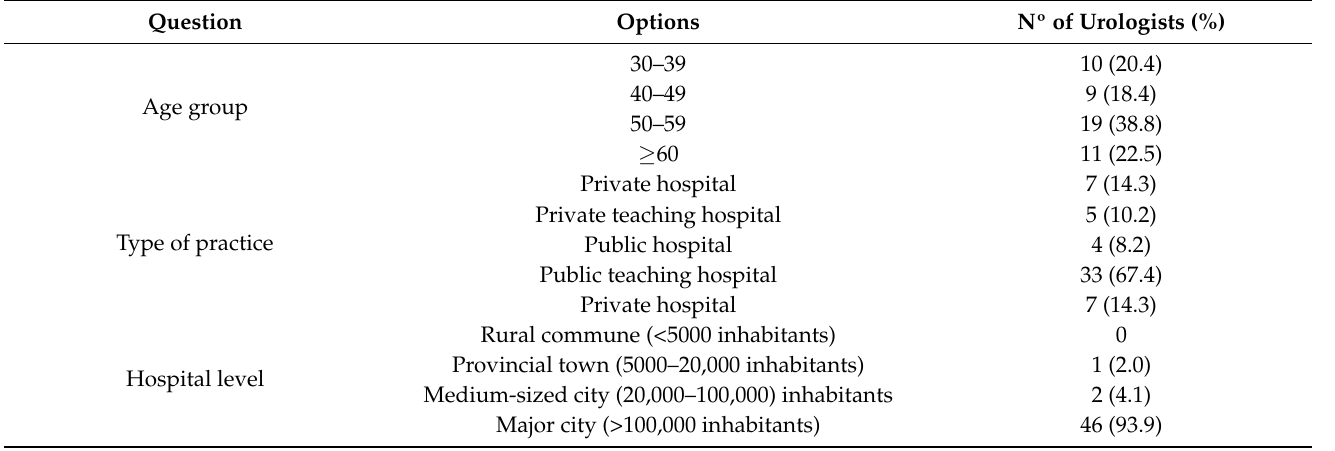
Table 1. Age distribution, hospital type and level.